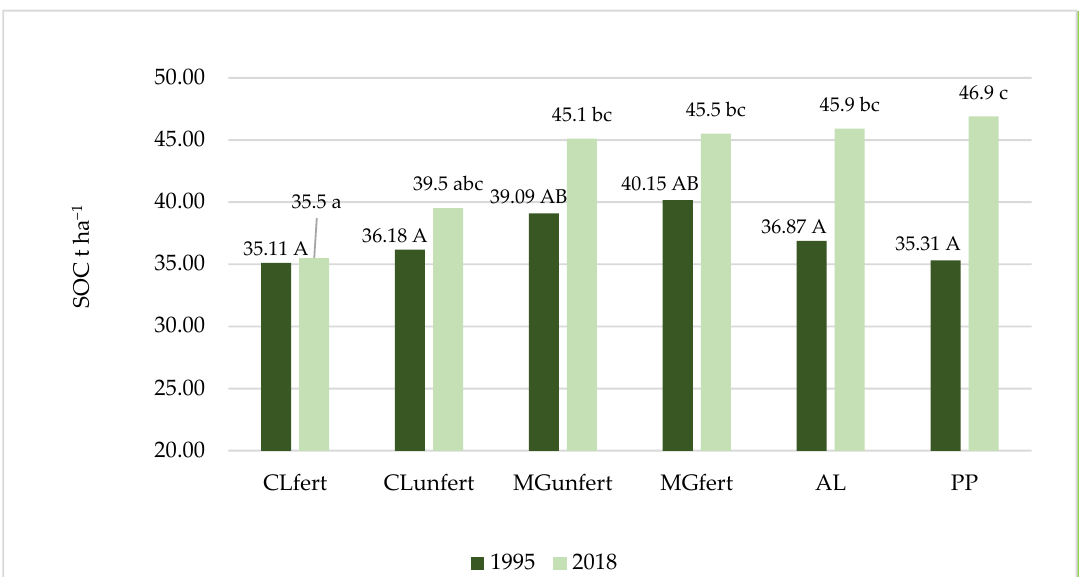
Figure 2. SOC stocks (t ha − 1 ) in A horizon of different land uses. Note. Abbreviations: CLfert: cropland fertilized; CLunfert: cropland unfertilized; AL: abandoned land; MGunfert: managed unfertilized grassland; MGfert: managed fertilized grassland; AL: abandoned land; PP: pine plantation. Capital letters indicate a significant difference between treatment in 1995 ( p < 0.05); lowercase letter indicate a significant difference between treatment in 2018 ( p < 0.05).